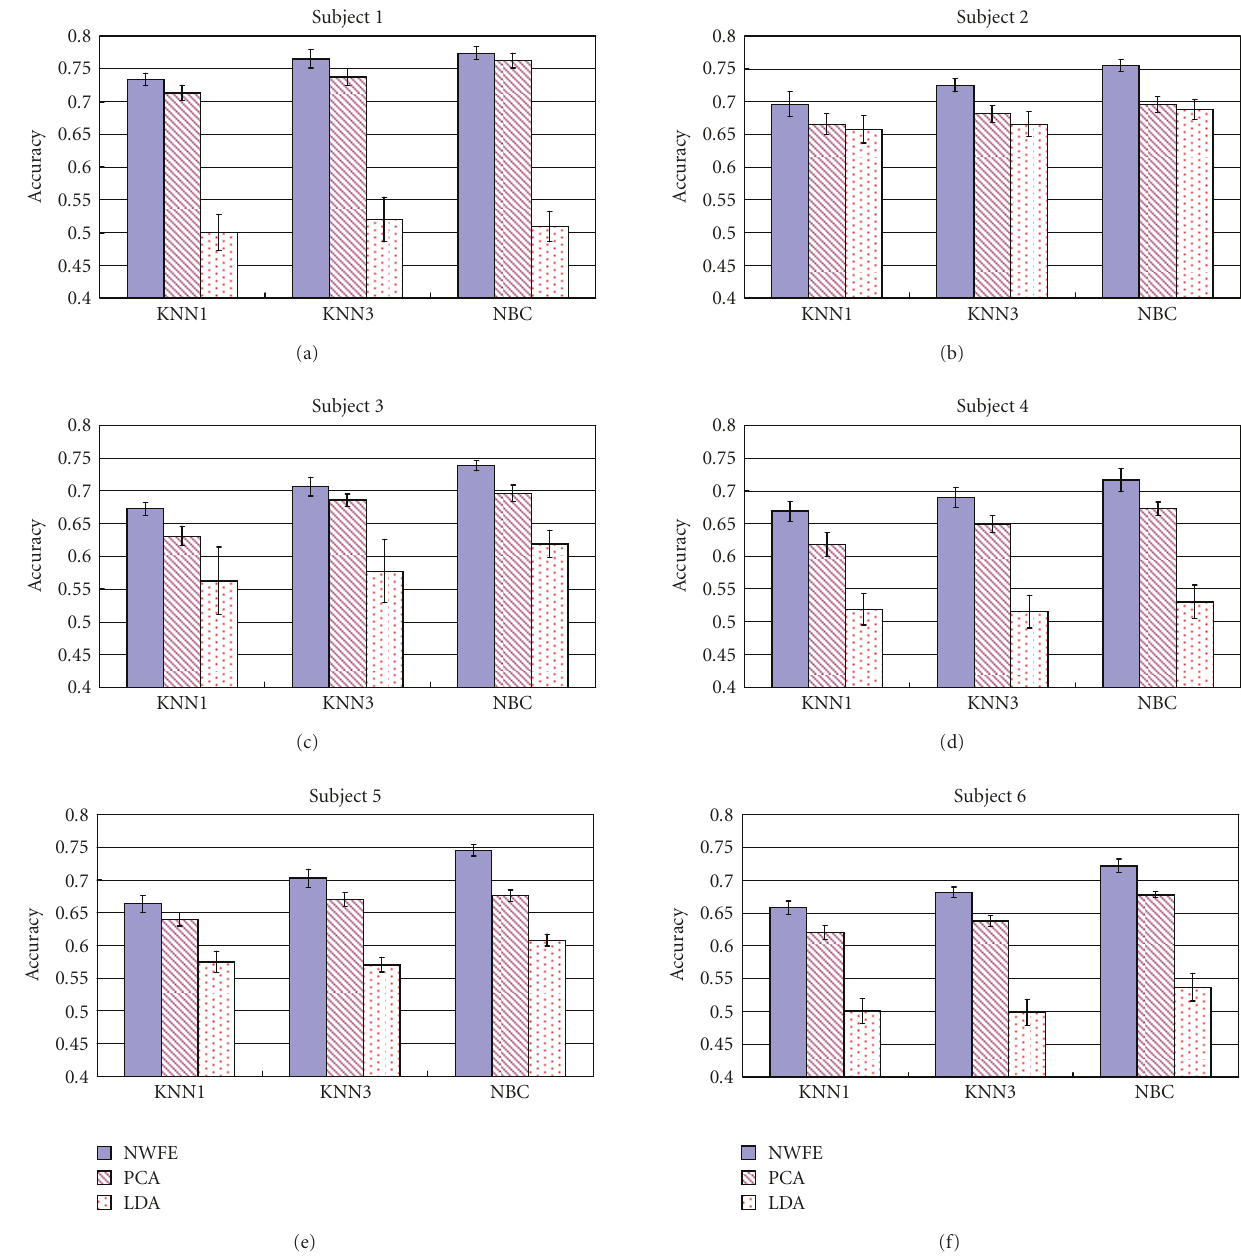
Figure 4: Classification results for six di ff erent subjects based on EEG signals from Pz